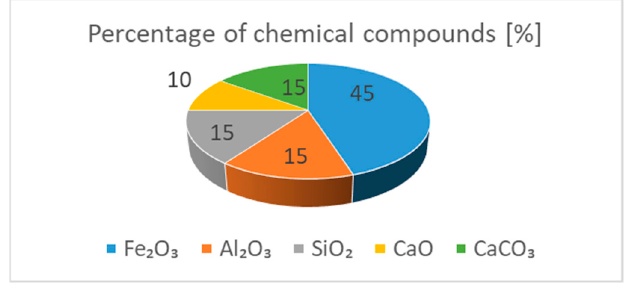
Figure 1. Percentage of chemical compounds in vermicompost [22].